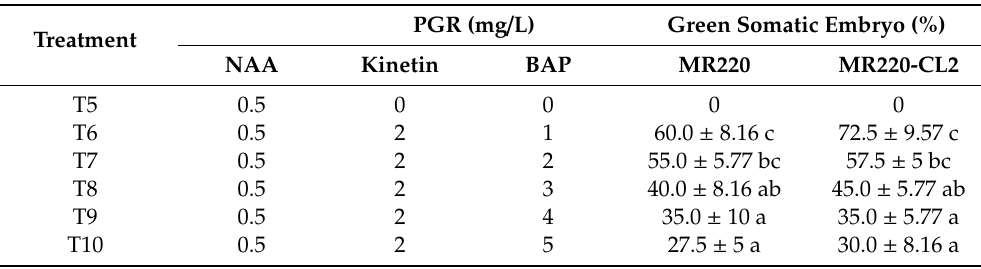
Value is a means of replicates ± standard error. The value of green spot percentage followed by different alphabet is significant differently at the 5% probability level according to Turkey’s multiple-range test.